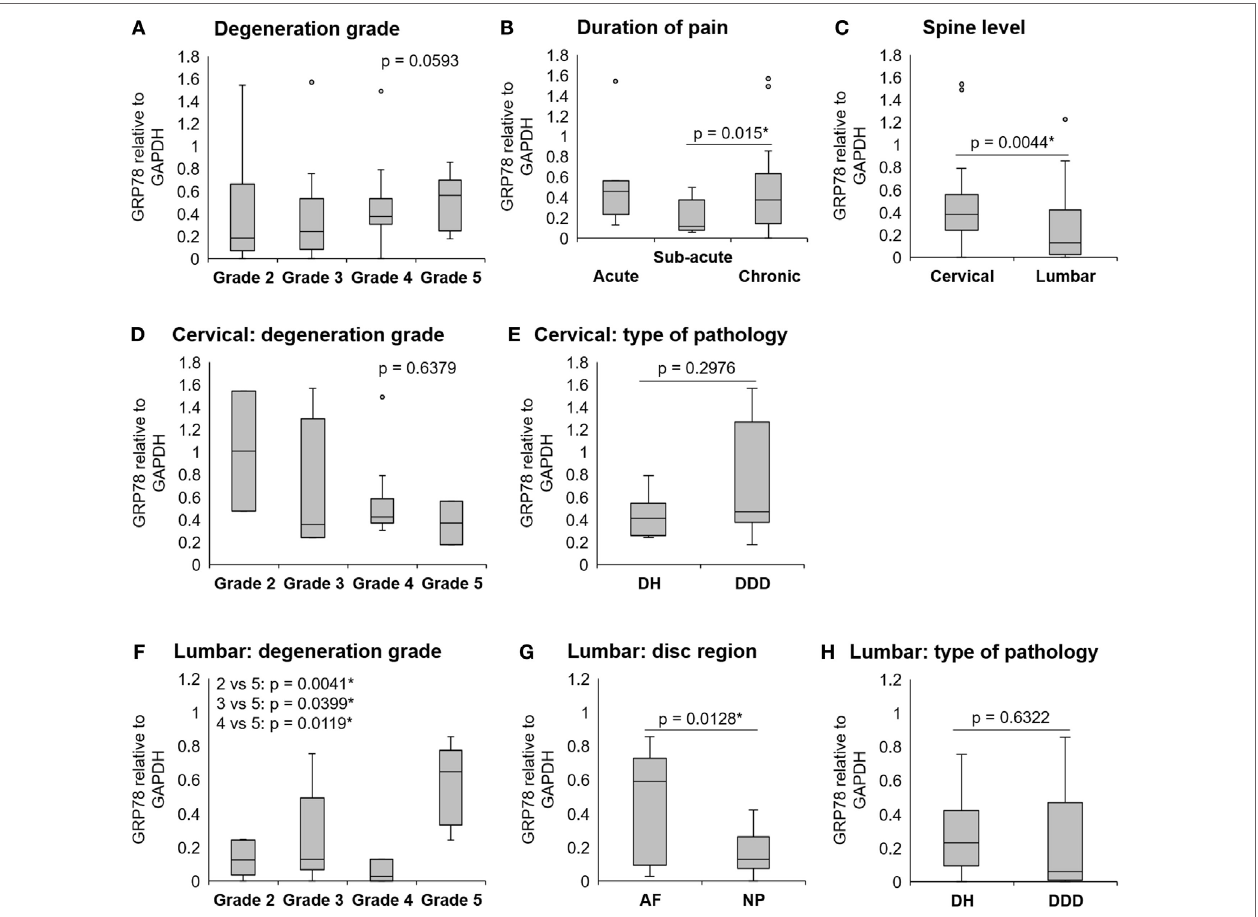
FigUre 1 | The expression of GRP78 in human degenerated intervertebral discs (IVDs). IVDs were collected from donors during spinal surgeries. Gene expression of GRP78 in cervical and lumbar IVDs ( n = 51 donors) (a) tended to increase with degeneration grade ( p = 0.0593) and significantly increased with (B) duration of pain ( p = 0.015) and (c) in cervical IVDs, when compared with lumbar IVDs ( p = 0.0044). (D) Gene expression of GRP78 in cervical IVDs ( n = 20 donors) was not significantly different between grades and (e) type of pathology. (F) Gene expression of GRP78 in lumbar IVDs ( n = 25 donors) increased with degeneration grade (2 vs 3 p = 0.0019, 2 vs 4 p = 0.0399, and 2 vs 5 p = 0.0041). (g) A difference in GRP78 expression was found between the disc regions [ n = 12 (AF), 15 (NP), p = 0.0128], but not (h) between different pathologies. Calculated as 2 −Δ Ct values (relative to GAPDH). Abbreviations: DDD, degenerative disc disease; DH, disc herniation; AF, annulus fibrosus; NP, nucleus pulposus.